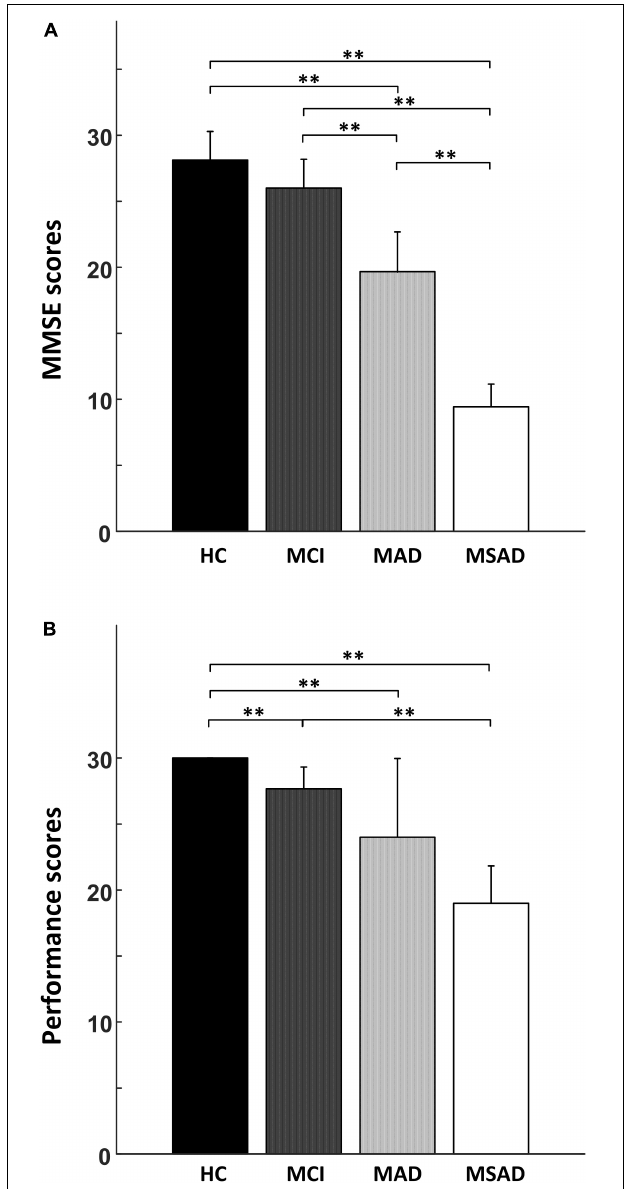
FIGURE 3 | The statistical analysis results of the behavioral measures. (A) The comparison of MMSE scores between all four groups; (B) The comparison of task performance between all groups. “ ∗∗ ” symbol denotes significant differences after Bonferroni-Holm